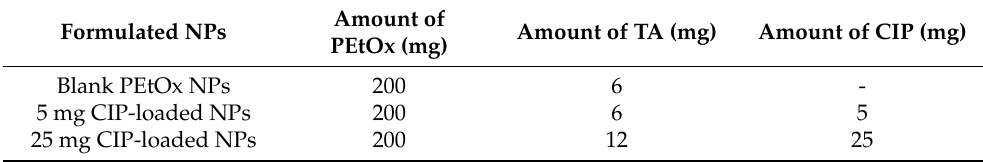
Table 3. Compositions of the compounds used in this study to formulate the